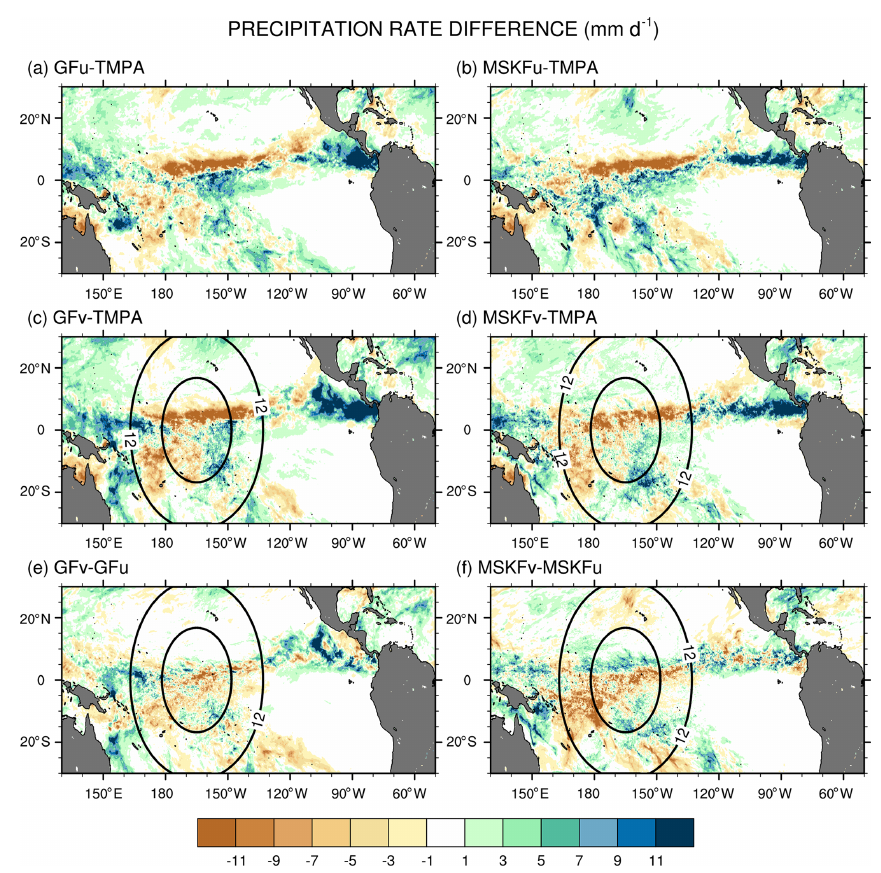
Figure 10. Monthly-mean precipitation rate difference over the tropical Pacific Ocean between (a, b) GFu (MSKFu) and TMPA data, (c, d) GFv (MSKFv) and TMPA data, and (e, f) GFv (MSKFv) and GFu (MSKFu) for December